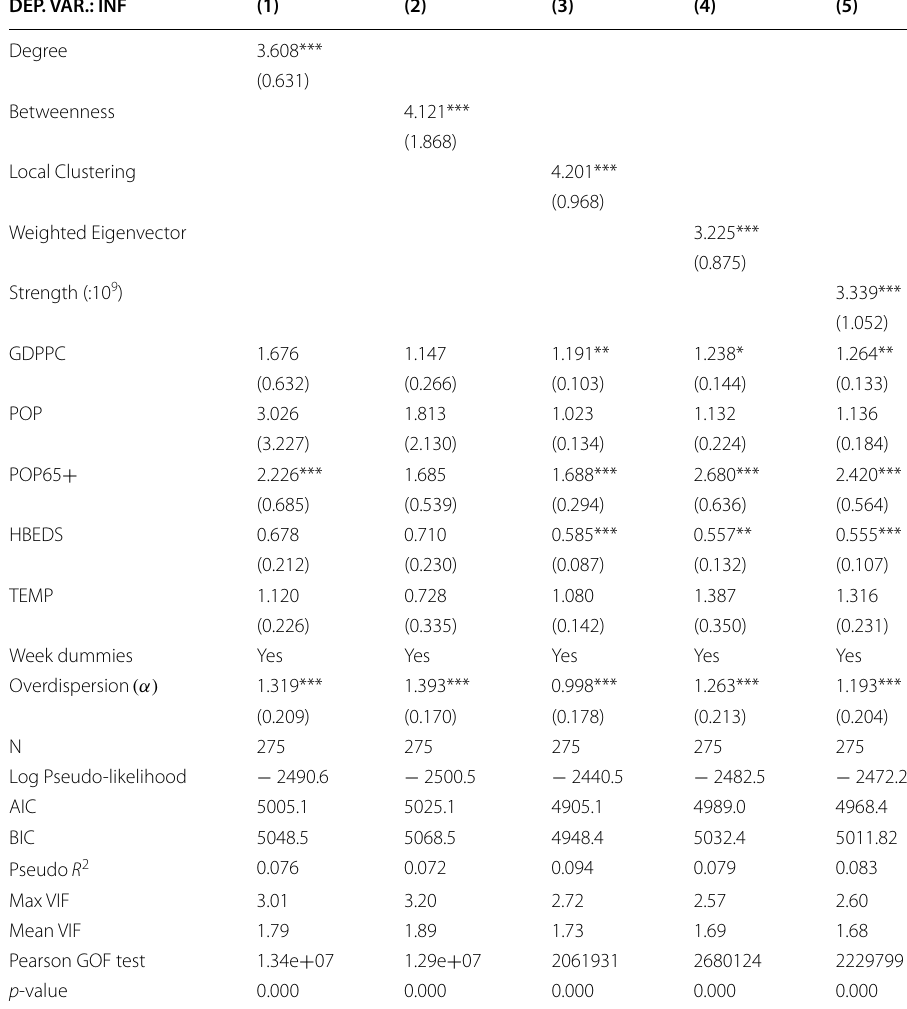
Country‑level clustered standard errors in